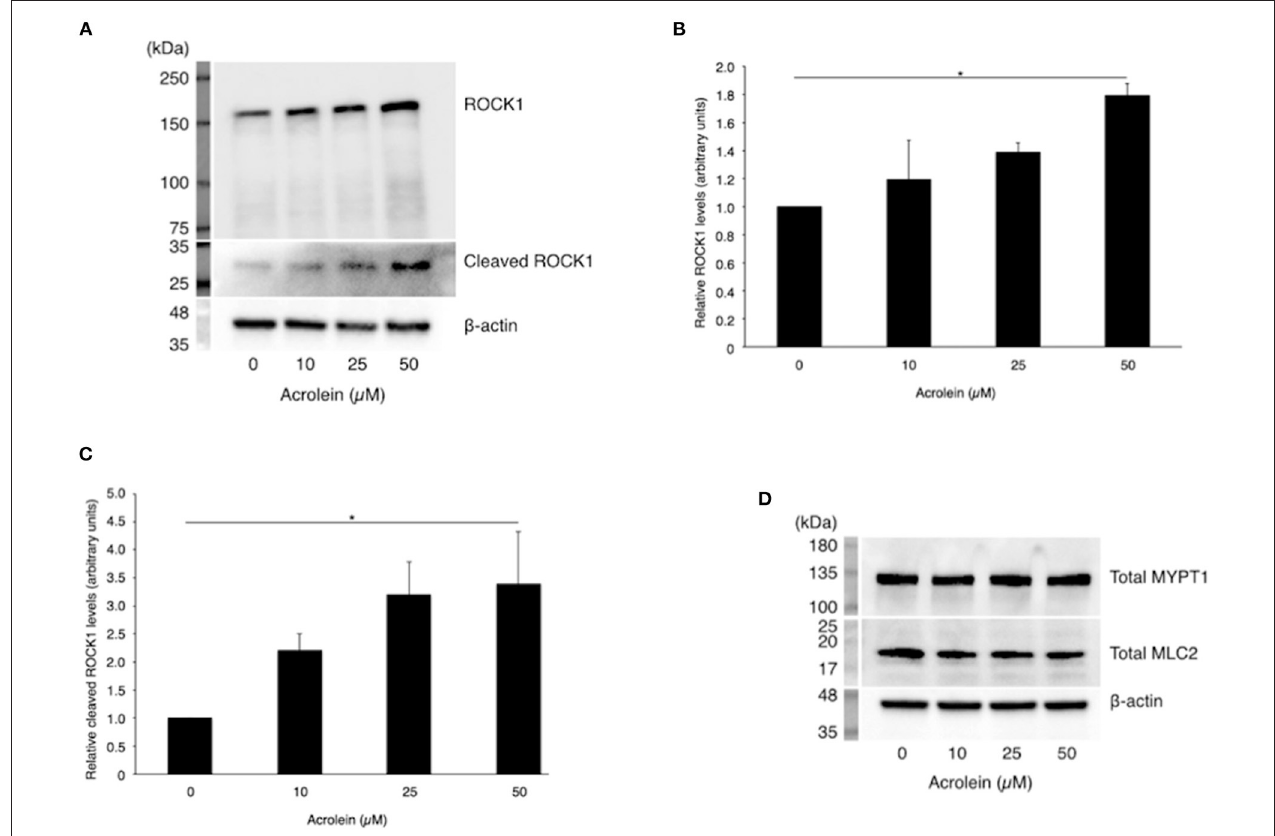
FIGURE 3 | Effect of acrolein on protein levels of ROCK1, MYPT1, and MLC2 in TR-MUL5 cells. (A) Western blotting of total and cleaved forms of ROCK1 protein when TR-MUL5 cells were incubated with acrolein (0–50 µ M). (B,C) Densitometric analysis of the bands. (B) Total forms of ROCK1 protein (0–50 µ M, n = 3 each). (C) Relative cleaved forms of ROCK1 protein (0–50 µ M, n = 4 each). (D) Total protein of MYPT1 and MLC2 in TR-MUL5 cells exposed to acrolein (0–50 µ M). Values represent mean ± SEM; * P < 0.05.